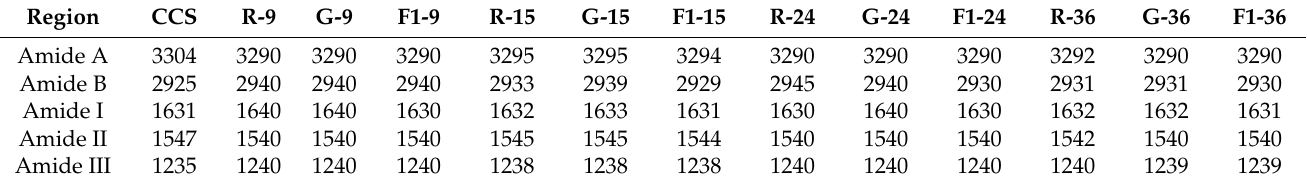
Table 3. Distribution of infrared spectroscopy of acid-soluble collagen extracted from the skin of tilapia ( Oreochromis niloticus ). CCS (collagen from calf skin—Type I); R-9, G-9, F1-9 (red, gray, and F1 of 9 months), R-15, G-15, F1-15 (red, gray, and F1 of 15 months); R-24, G-24, F1-24 (red, gray, and F1 of 24 months); R-36, G-36, F1-36 (red, gray, and F1of 36 months).